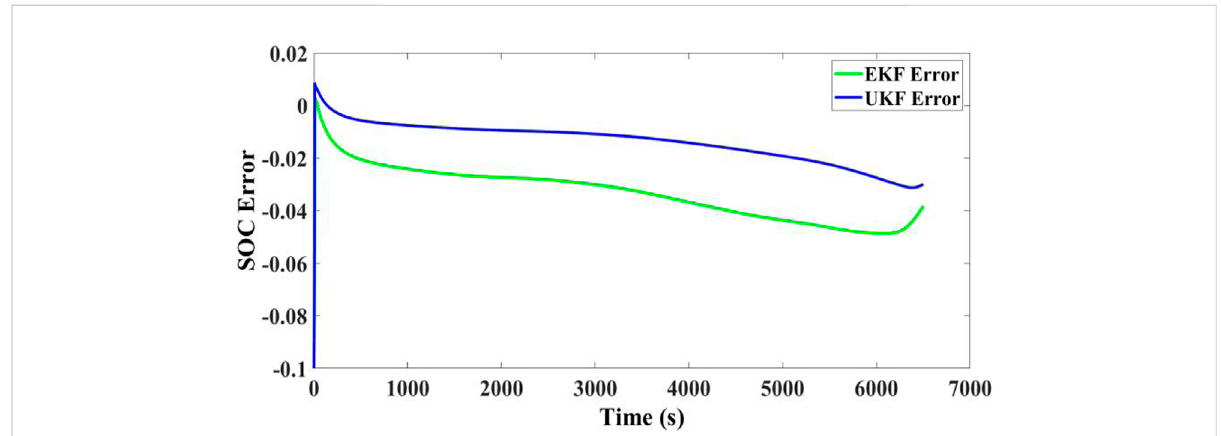
FIGURE 7 Comparison of SOC estimate error under constant current discharge.